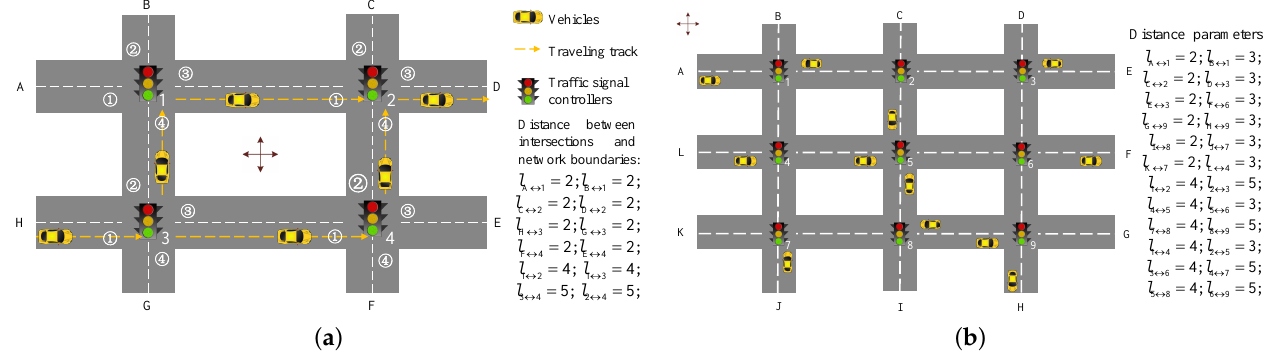
Figure 1. Road networks in a smart city. ( a ) Scenario 1: simple traffic unit, ( b ) Scenario 2: complex traffic